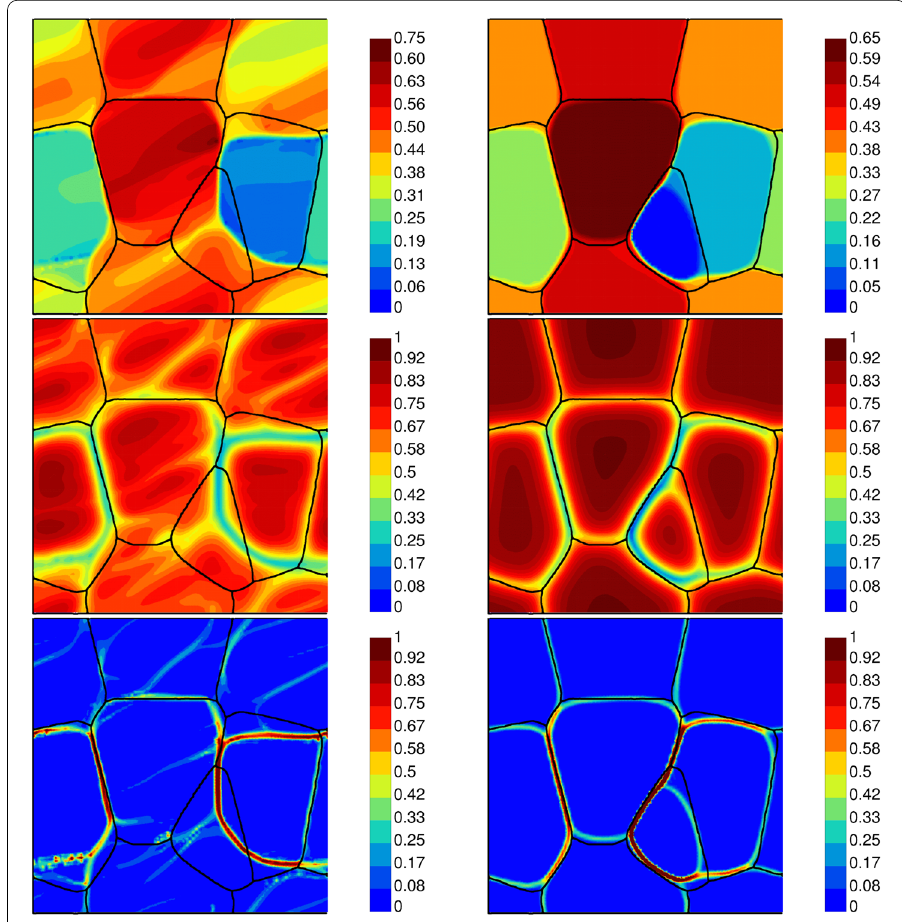
Fig. 8 The microstructure after 2h of constant shear deformation at moderately elevated temperature. The simulations allow one (left) or four (right) possible active slip systems. From top to bottom the images show the orientation field, the phase-field φ and the curvature |∇ θ | . The original grain boundaries are outlined in black. The initial microstructure is the same in both